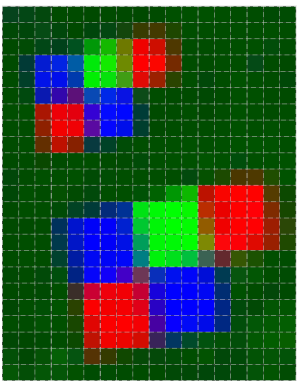
Figure 14. Detail of Figure 13b for abundances computed with the NNLS algorithm on the 3 and 2m targets, with grid showing single image elements overlaid.